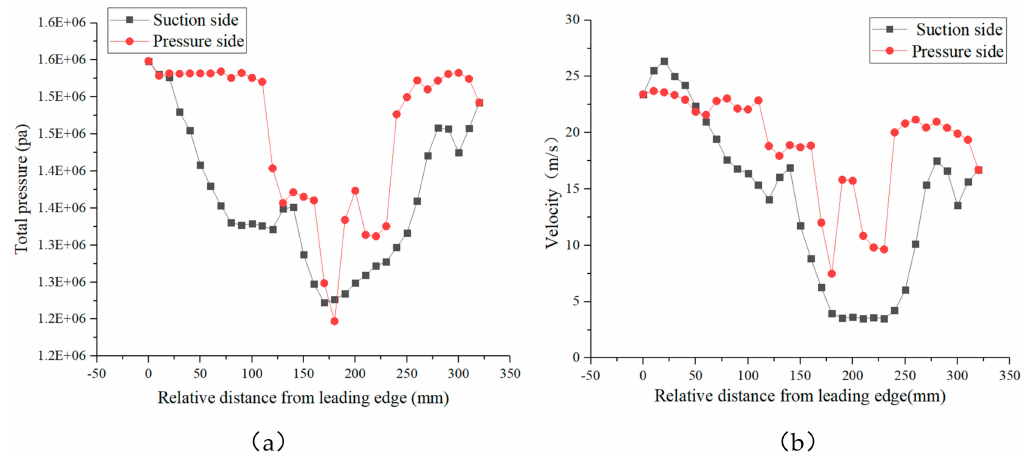
Figure 12. Velocity and pressure measurements along the clearance mid-span: ( a ) Pressure; and ( b ) velocity.